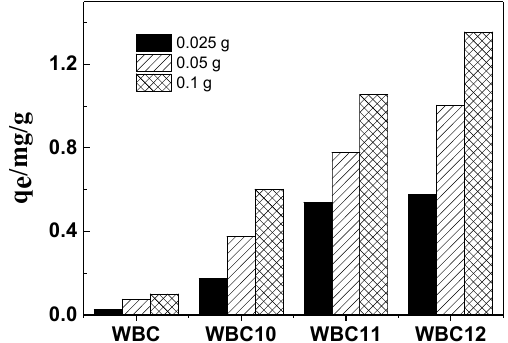
ff ects of di ff erent adsorbent doses on phosphate Figure 7. Effects of different adsorbent doses on phosphate adsorption. Figure 7. E Figure 7. Effects of different adsorbent doses on phosphate adsorption.